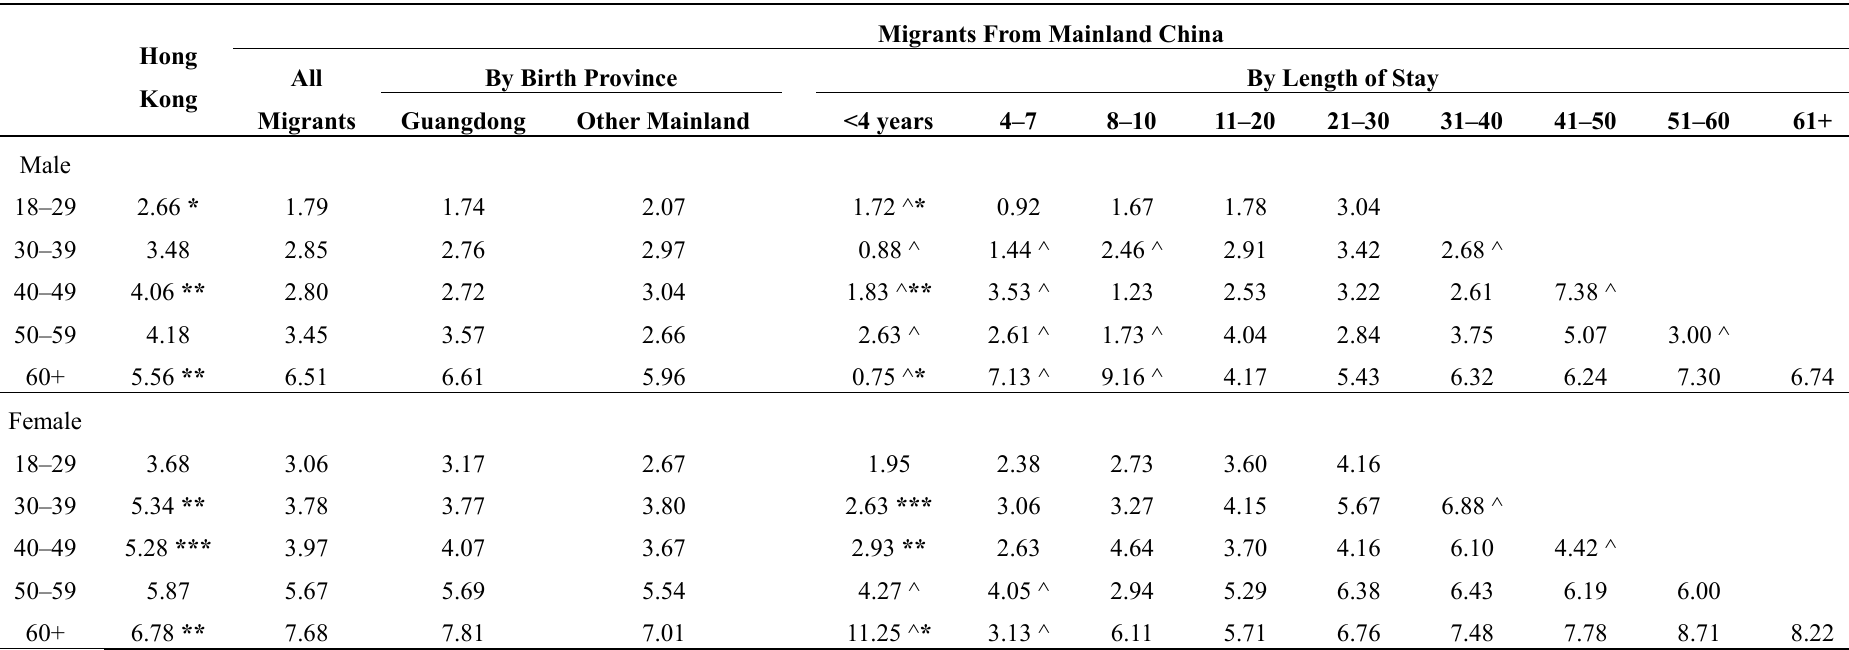
Migrants From Mainland China